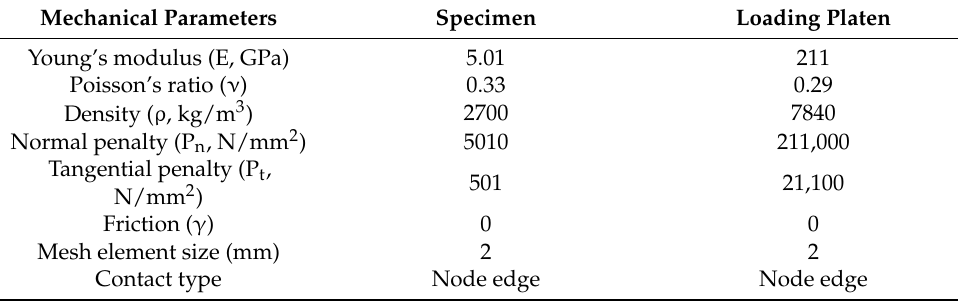
Table 4. The strain energy of each part.